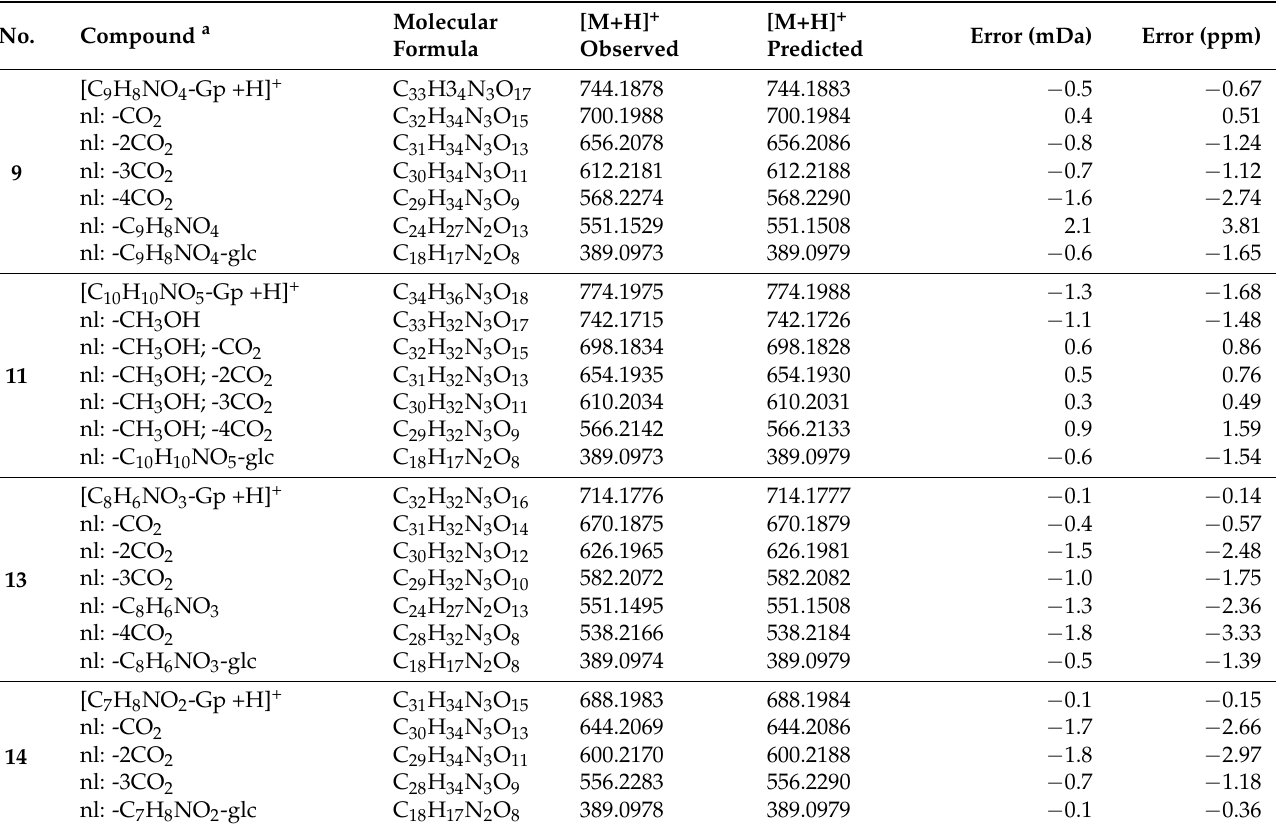
Table 3. High-resolution mass spectrometric data obtained by analysis of B. alba and B. alba var. ‘Rubra’ fruit juices by the Orbitrap system indicating the presence of novel natural betacyanins acylated with nitrogenous